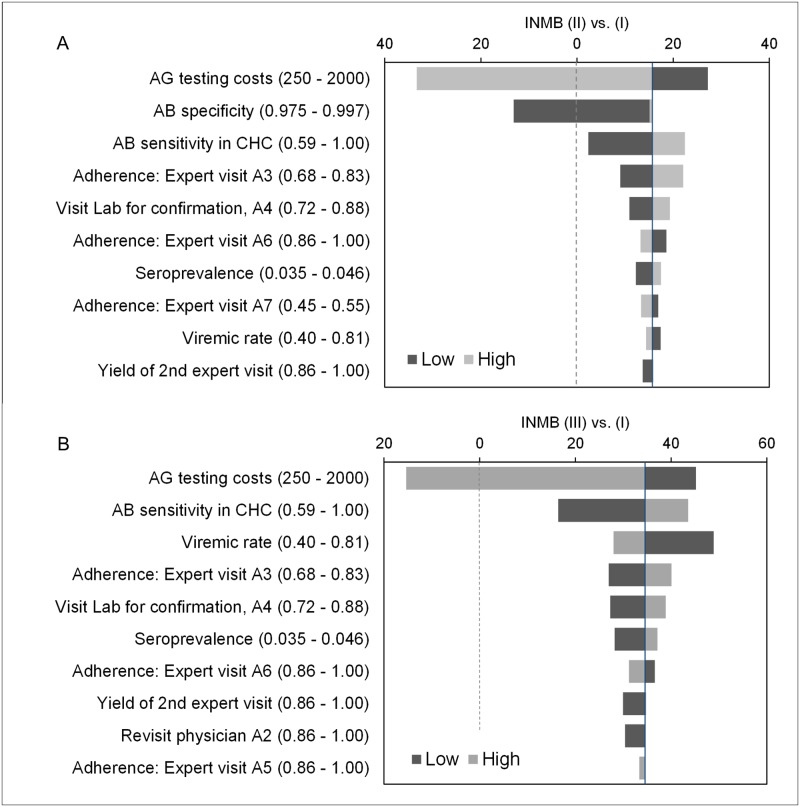
One-way sensitivity analyses tornado diagrams.Tornado diagrams from multiple one-way sensitivity analyses on all variables within the ranges stated in brackets. A: Incremental net monetary benefit (INMB) for Strategy II vs. Strategy I. B: INMB for Strategy III vs. Strategy I. NMB calculations based on WTP of 2,000 Rubles ($82). The vertical line represents the expected values using each variable’s base case value. The dotted line indicates a change of the preferred strategy within the range tested. Variables not presented here did not show an effect.